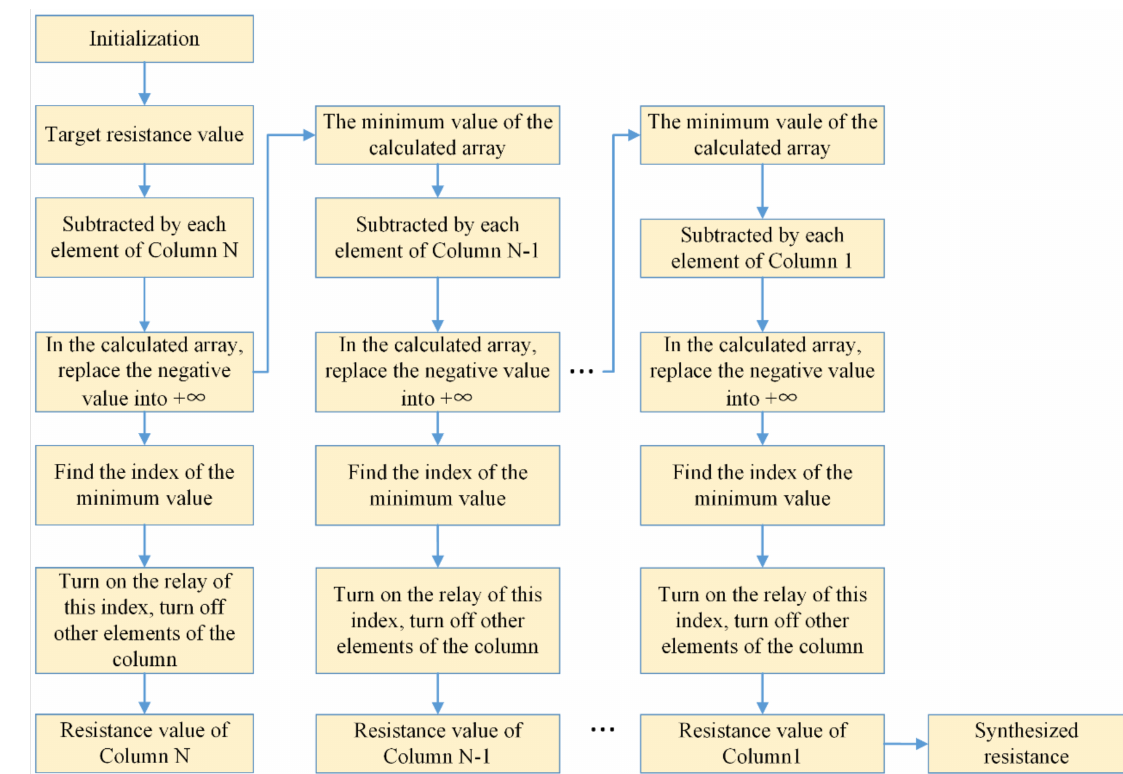
Figure 3. Flowchart of the resistance schedule algorithm.